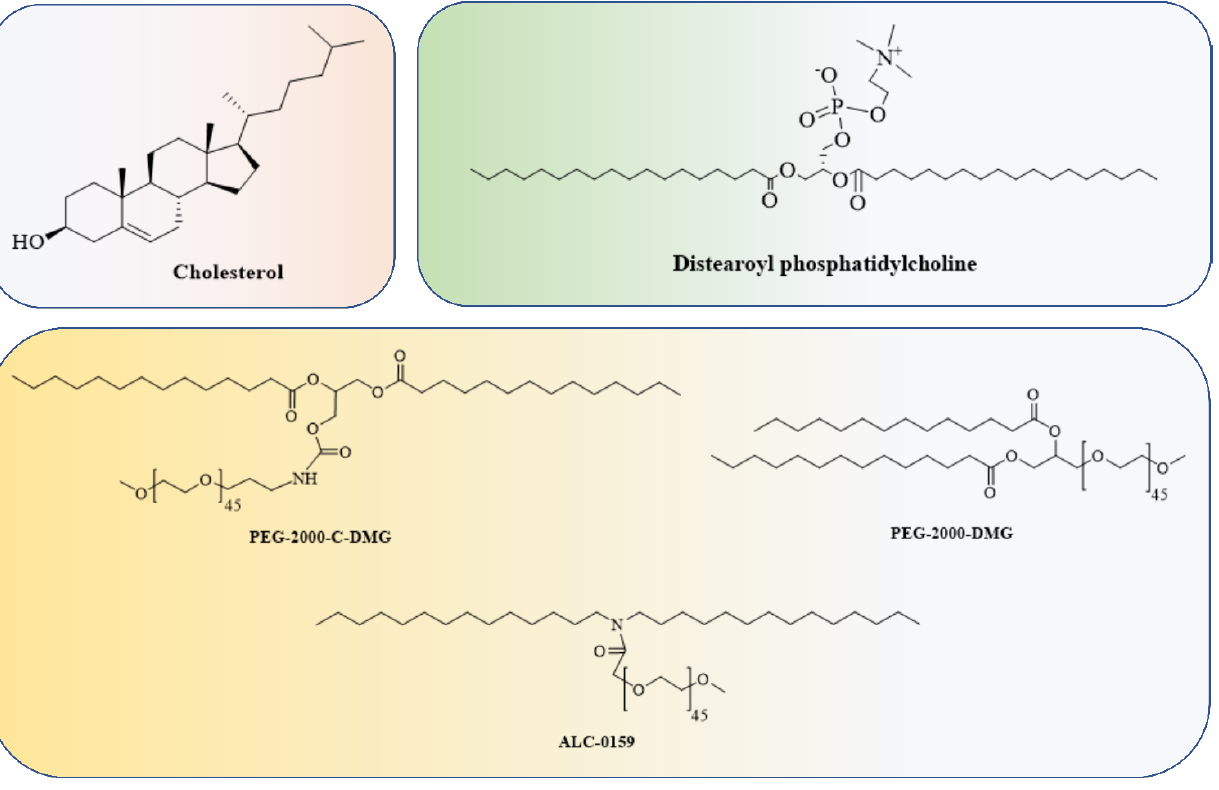
Figure 2. Cholesterol, a helper lipid, a PEG-lipid, and the RNA payload are common components of LNPs.